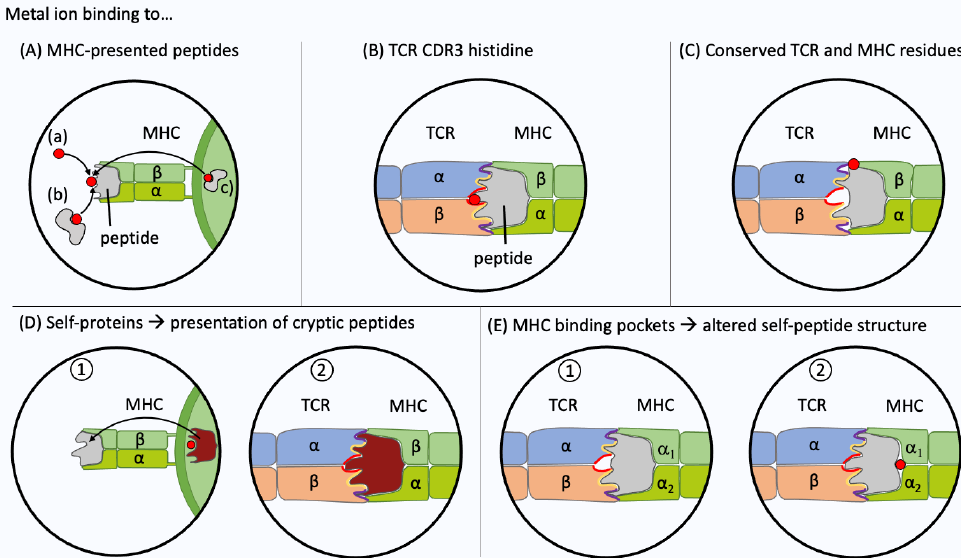
Figure 4. Metal recognition by T cells. Experimental evidence has been obtained for five different interactions between the T cell receptor (TCR), the metal ion (highlighted in red) and the peptide presented at the surface of the major histocompatibility complex (MHC). ( A ) The metal ion haptenizes the presented peptide. Loading can occur directly from the extracellular space (a) or by transfer from a metal-binding protein [232] (b). The metal ion may also be pre-loaded to the MHC-presented peptide, e.g., by antigen-processing of a metal-binding protein (c). ( B ) Metal ion binding at the TCR complementarity-determining region 3 (CDR3). The metal ion may bind to the TCR CDR3. Recently, frequent Ni 2+ binding via a histidine in the CDR3 of TCR α- or β-chain has been shown [115]. ( C ) Metal ion binding to conserved residues at the TCR-peptide-MHC interface. Ni 2+ ions often bind via tyrosine 36 in the CDR1 of TRAV9-2+ TCR and histidine 81 in the MHC II β- chain [114,115]. ( D ) Recognition of cryptic epitopes. Metal ions may alter antigen-processing of a self-protein which in turn leads to the presentation of a metal-free cryptic self-peptide. ( E ) Metal ions may bind within the cleft between MHC and antigen peptide. The TCR is not activated by a self-pMHC complex (1). The metal ion binding leads to structural conformation changes of the presented peptide and creates a metal-free neo antigen recognized by the TCR (2). This type of interaction has been shown for beryllium (II) ions in combination with HLA-DP2 [233]. The activation of metal reactive T cells likely requires a metal-mediated bridge be- tween the TCR and pMHC complex in most cases [7]. Metal ions can directly interact with endogenous peptides bound to the MHC (Figure 4A). The TCR can then recognize the metal ion which is present on the pMHC. Ni-binding to the amino acid histidine in an MHC II-presented peptide (CS325-341 EPSDK H IEQYLKKIKNS) has been shown by NMR spectroscopy (Figure 4A(a)). The “empty” peptide activated a CS325-341-specific TCR (clone HM.37), the addition of Ni 2+ prevented this interaction [234]. Similarly, the addition of Au (III) inhibited the activation of a CST3 (CS378-398 DIEKKICKMEKCSSVFNVVNS)- specific TCR (clone BH26). In this latter case, the peptide does not contain a histidine and the position of Au 3+ remains speculative [235]. Possibly, Au 3+ stripped the peptide from the MHC II and this abolished TCR activation [236]. Metals may be transported in human skin and blood by Ni-binding co-mediators to- wards the vicinity of the MHC molecule. Thierse et al. showed that activation of Ni-spe- cific CD4+ T cells via a Ni-saturated human serum albumin complex can be comparable to activation by metal salts at equimolar concentrations. The human serum albumin was not used as an antigen on the MHC but only served to transfer Ni ions (Figure 4A(b)) [232]. The metal ion may also bind to proteins that undergo antigen processing. Fixation of APC with, e.g., glutaraldehyde, has been used by several groups to distinguish extracel- lular metal ion binding from intracellular processing of metal-binding proteins (Figure 4A(c)). Moulon et al. studied 42 CD4+ MHC II-restricted T cell clones. They showed that 40 % of the clones were unable to recognize Ni 2+ on the surface of fixed APC [188]. If the